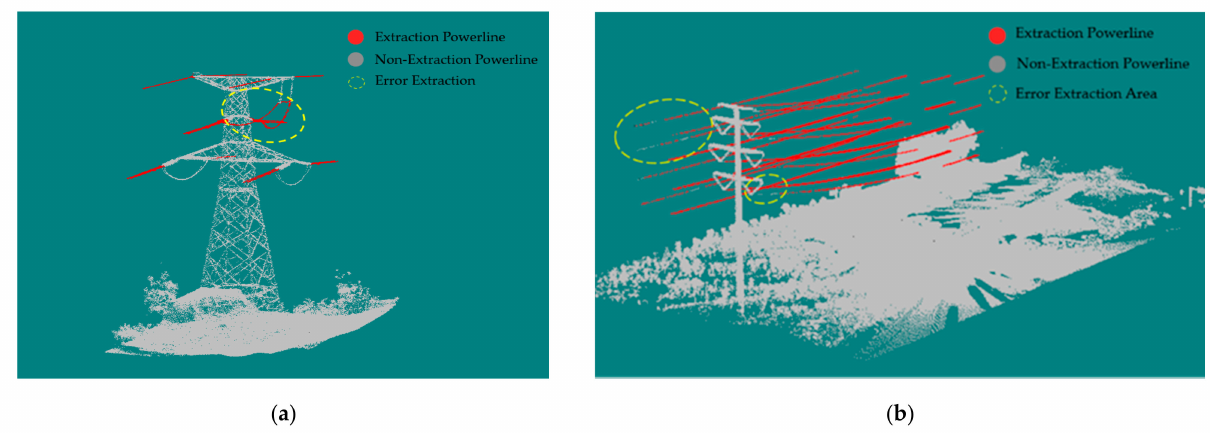
Figure 10. Extracted results. ( a – d ) represent the qualitative results of Dataset 1–4, respectively. The extracted PTL points were labelled with red color. The zoomed pictures show the extraction effects of pylon connections or complex scenes.